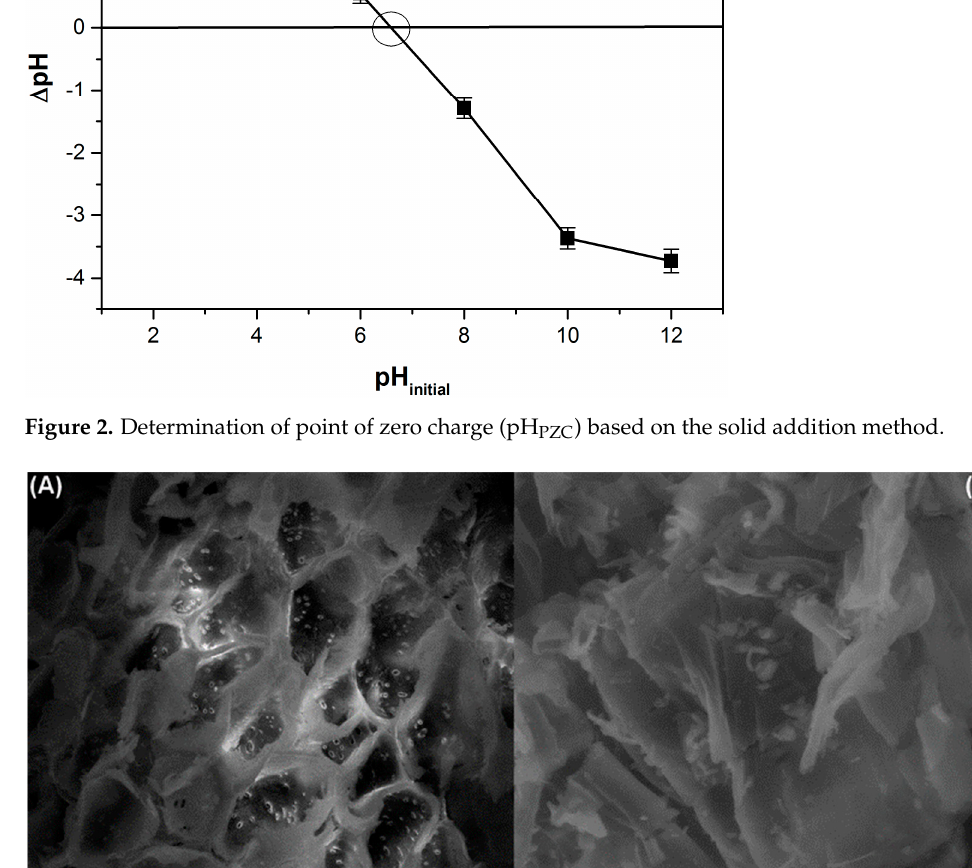
Figure 2. Determination of point of zero charge (pH PZC ) based on the solid addition method.